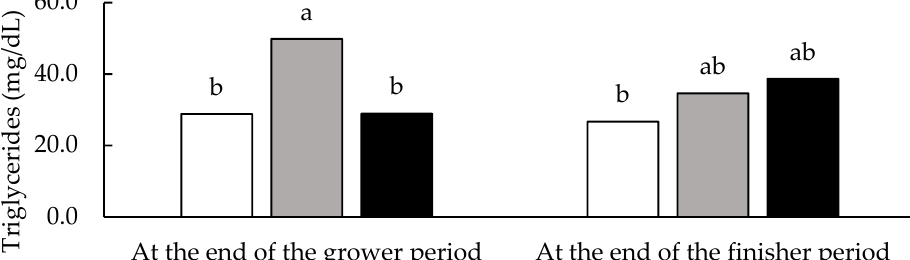
Figure 1. Significant interaction ( p = 0.031) between diet and sampling time on serum triglyceride concentration of heavy gilts. The average body weight of gilts at the end of the grower period was 102 kg and at the end of the finisher period was 134 kg. Statistical evaluation was carried out with data after their transformation. Data are presented as back-transformed least square means. Different letters (a,b) denote significant differences between treatments ( n = 8) ( p < 0.05).